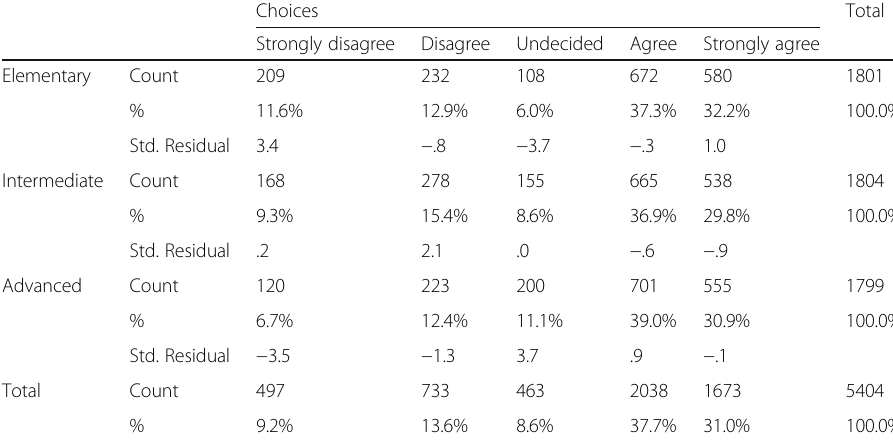
Table 8 Frequencies, percentages and standardized residuals of the efl learners ’ proficiency-based perceptions towards explicit grammar instruction and corrective feedback Choices Total Strongly disagree Disagree Undecided Agree Strongly agree Elementary Count 209 232 108